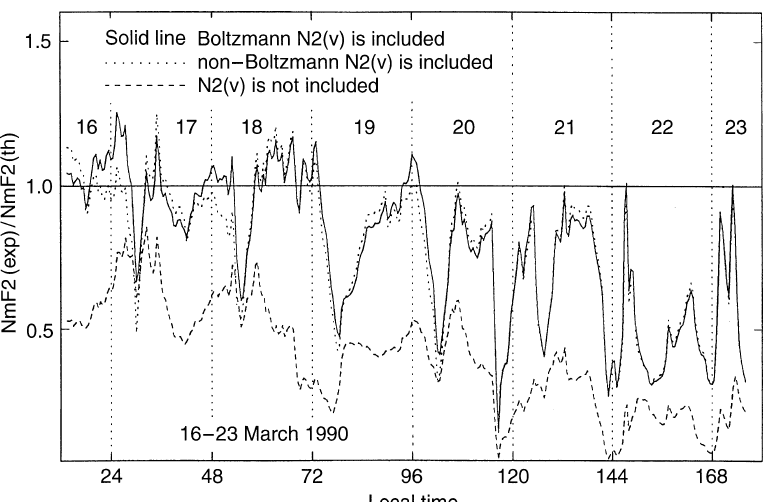
Fig. 3. Ratios of the measured F2 peak densities NmF2(exp) to the modeled F2 peak densities NmF2(th) during the 16–23 March 1990 period for the EUVAC solar flux model. The modeled NmF2 were obtained using the Boltzmann vibra- tional distribution of N 2 (cid:133) v (cid:134) ( solid line ) and the non- Boltzmann populations of the first five vibrational levels by solving the N 2 ( v = 1–5) time-dependent continuity equations ( dotted line ), and when N 2 ( v ) was not included in the calculations ( dashed line ). The original O (cid:135) (cid:133) 4 S (cid:134) recombination rate was decreased by the factor 1.5 during the nighttime periods 16–18 and 19–20 March and the O (cid:135) (cid:255) O collision frequencies given by Salah (1993) were used in the IZMIRAN